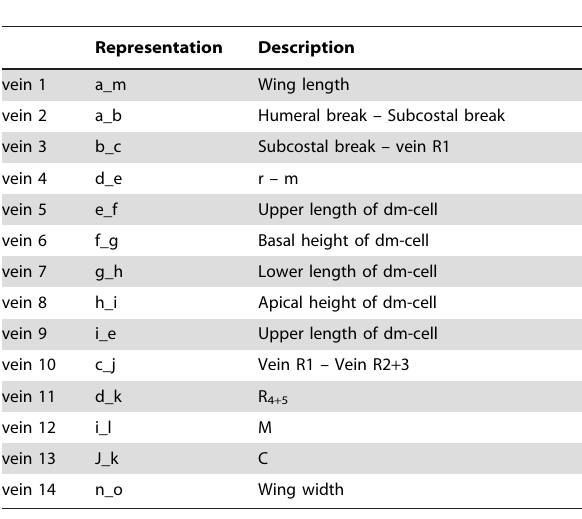
Table 5. Key of the veins used in morphometrics